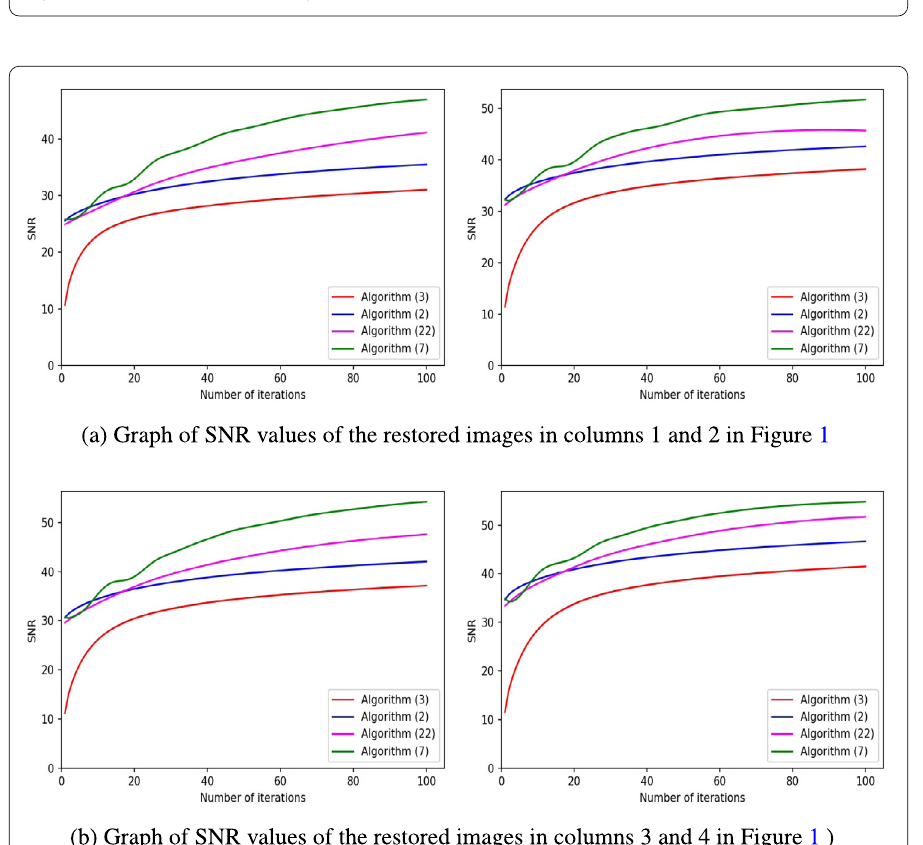
Figure 3 Graphical presentation of the SNR values of the restored images in Fig.